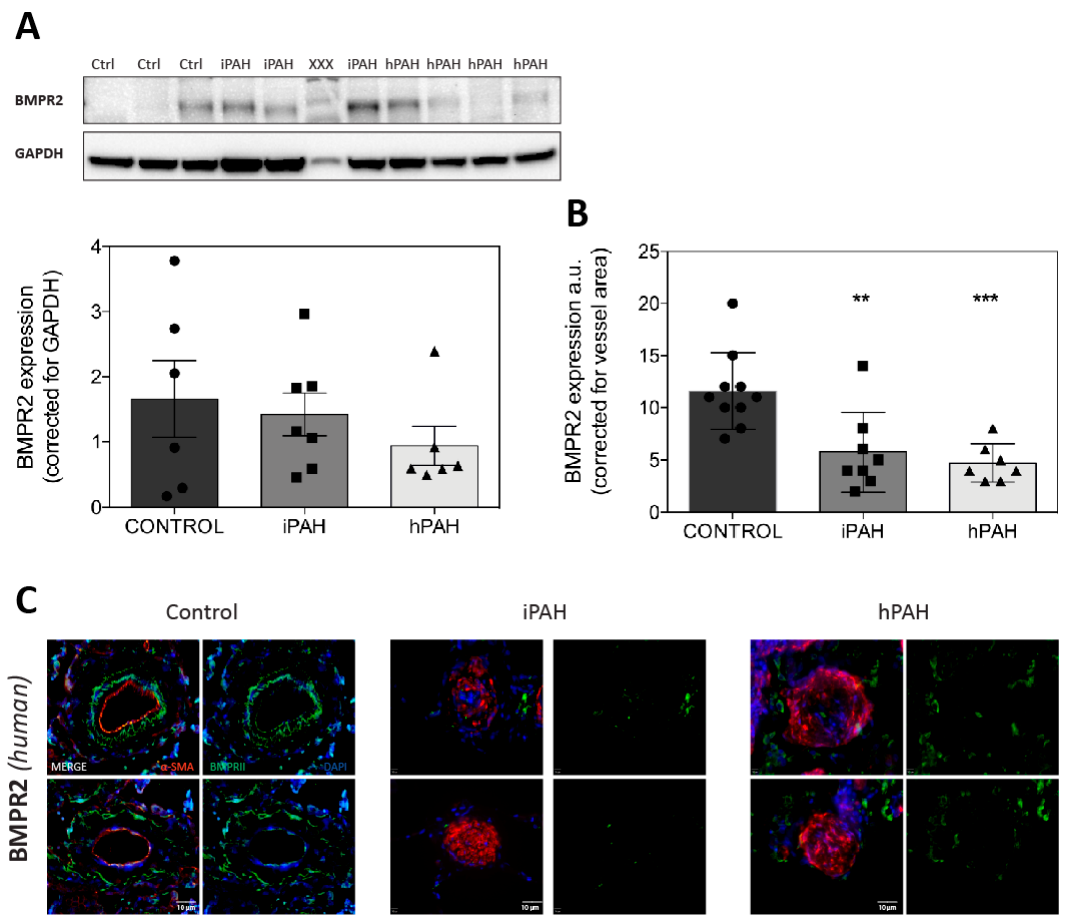
Figure 1. Western blot analysis of BMPR2 protein expression in the whole lung homogenates of idiopathic PAH (iPAH) and hereditary PAH (hPAH). ( A ): BMPR2 expression in the whole lung homogenates. xxx = non-relevant sample. ( B ): BMPR2 expression corrected for the vessel area. ( C ): Typical examples of vessels are shown. Green = BMPR2; red = smooth-muscle-actin ( α -SMA); blue = nuclei. ** = p < 0.01 / *** = p < 0.001.